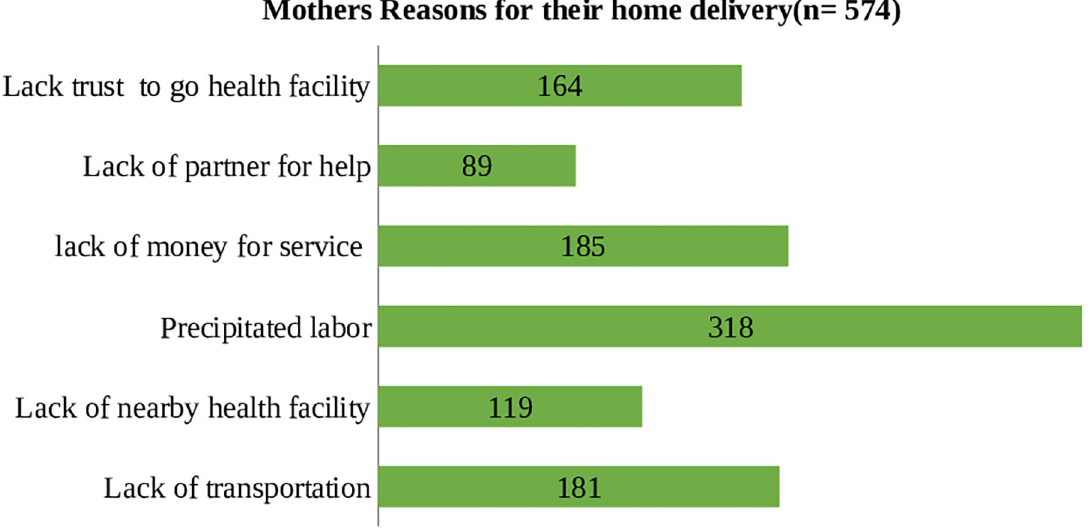
Fig 1. Reasons of postpartum women for their home delivery, in Guto Gida district, Oromia regional state, Ethiopia, 2020, (n = 574).